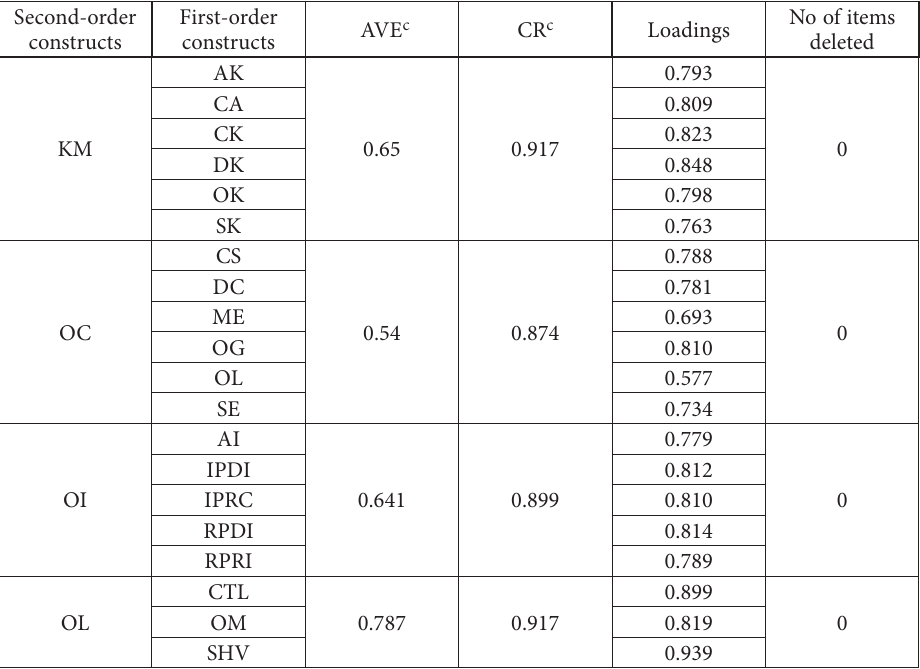
Table 4. The result of measurement model – Convergent validity assessment